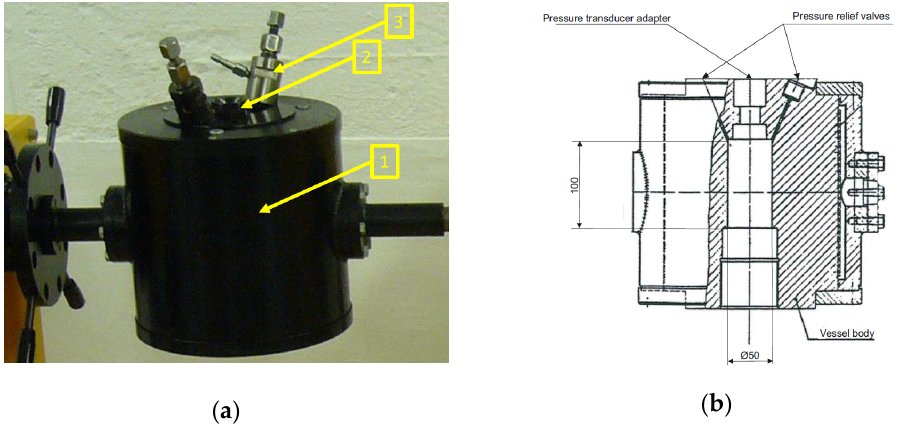
Figure 1. Closed vessel HPI B180T: a – appearance; b – cross-section (1—closed vessel with jacket, 2—pressure transducer adapter, 3—pressure relief valve).